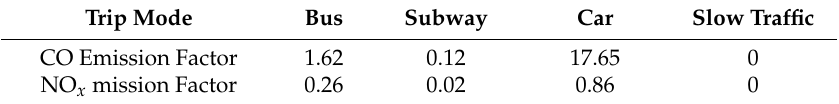
Table 1. Transportation default pollutant emission factors for different trip modes (g/p.km).